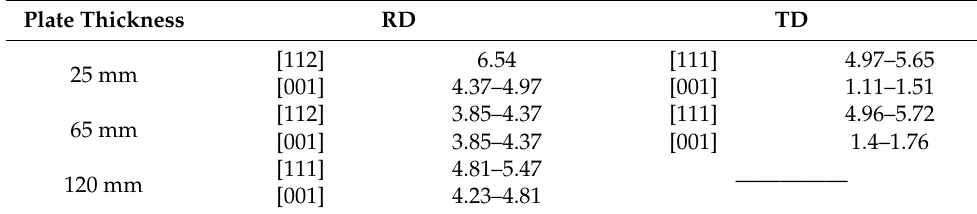
Table 2. The orientations and orientation densities of different plates.